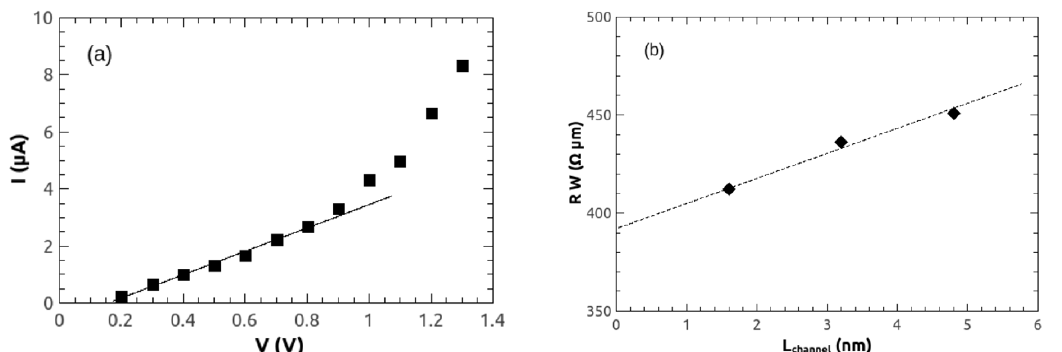
Figure 2. ( a ) Computed current–voltage (I–V) characteristics of a 1T-MoS 2 /2H-MoS 2 /1T-MoS 2 heterostructure. The resistance R of the structure is extracted from a linear fit to the data (solid line), in the voltage range between 0.2 and 0.8 V. ( b ) Resistance (multiplied by the channel width W) of the same heterostructure, for three different 2H-MoS 2 channel lengths. The dashed line is a linear fit to the data.